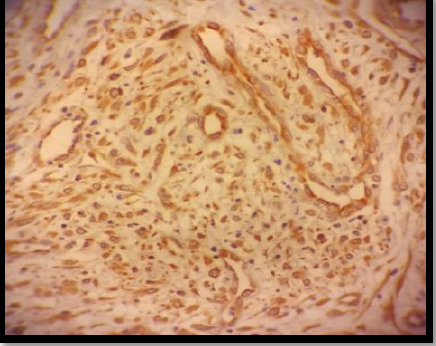
Figure (5): Photomicrograph in lobular capillary hemangioma viewing ESM-1 immunostaining- positive blood vessels